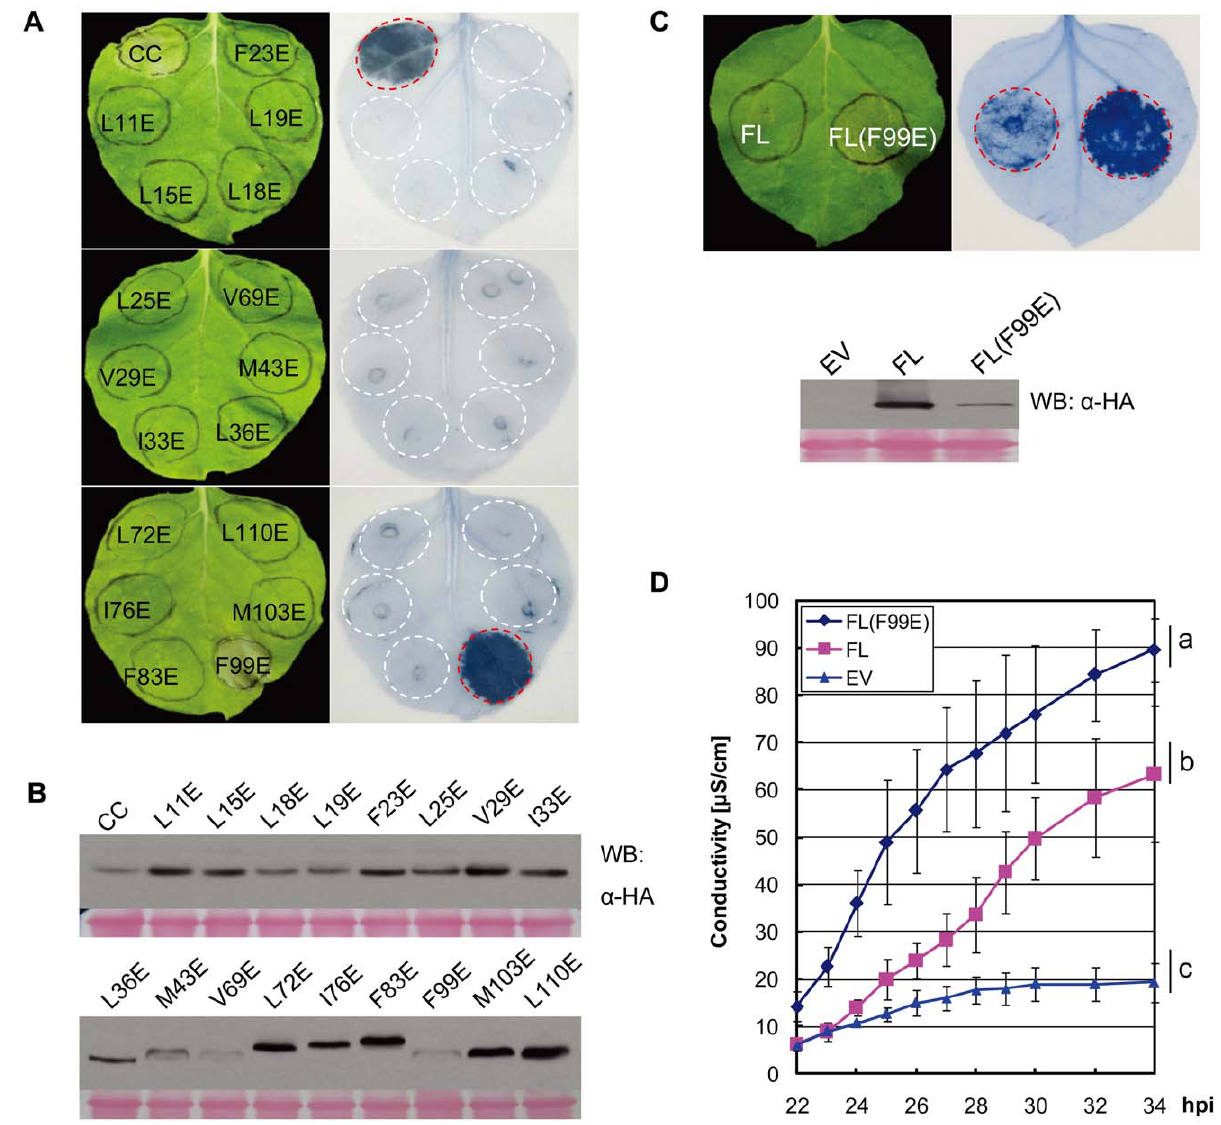
Figure 2. Glutamate substitution analyses in the MLA10 CC domain identify the F99E autoactive mutation. ( A ) Analysis of cell death inducing activity of MLA10 CC mutant variants. MLA10 CC wild-type or mutant variants harboring indicated amino acid substitution were expressed in N. benthamiana leaves, and cell death induced by each protein was visualized by trypan blue staining at 42 hpi (upper panel). ( B ) Protein expression levels of each CC variant shown by Western blotting. Proteins were extracted from N. benthamiana leaves at 40 hpi and detection was done by immunoblotting with anti-HA antibody. ( C ) Comparison of cell death inducing activity of MLA10 FL and the FL(F99E) variant. FL and FL(F99E) were expressed on the same N. benthamiana leaf, and the amount of cell death induced by each protein was shown by Trypan blue staining at 24 hpi (upper panel); protein expression levels of FL and FL(F99E) were shown by protein immunoblotting analysis using anti-HA antibody (bottom panel), protein extracts were obtained at , 22 hpi. ( D ) Quantification of cell-death inducing activity of FL and FL(F99E). Upon expression of FL or FL(F99E) by Agro-infiltration in N. benthamiana , electrolyte leakage was measured each hour from 22 to 30 hpi, and then every two hours from 30 to 34 hpi; empty vector (EV) was included as a negative control. Error bars representing standard error (SE) were calculated from three replicates per time point and per construct. Similar experiments were repeated at least twice with similar results. Letters (a–c) represent significant differences [ p , 0.05, Tukey’s honest significant difference (HSD)